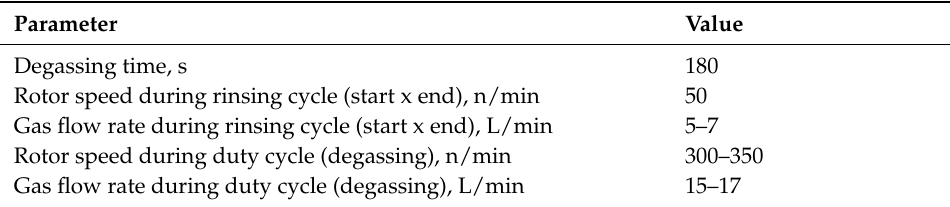
Table 2. Technological parameters of the refining process.